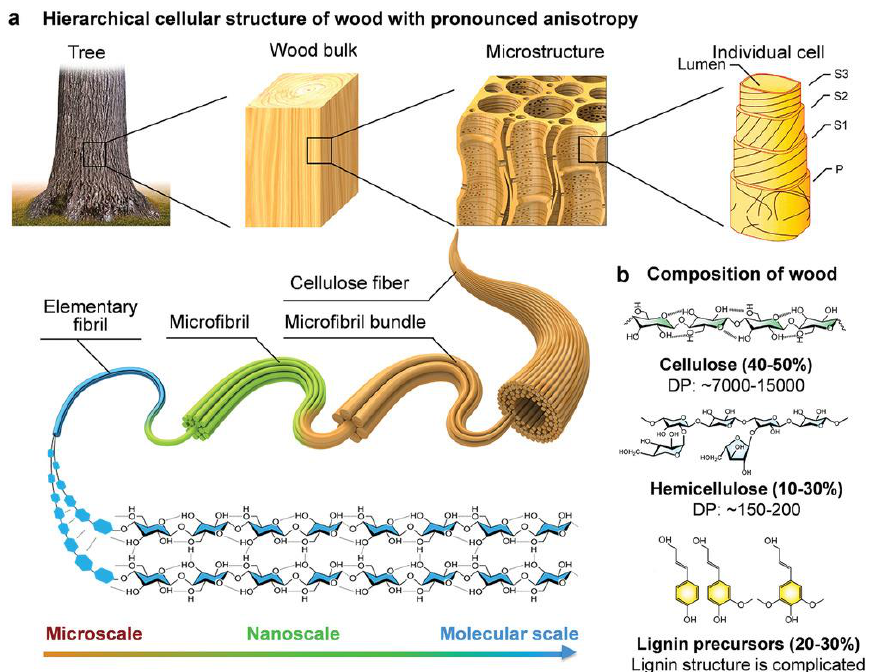
Figure 4. Hierarchical structure of wood and its composition. ( a ) Hierarchical cellular structure of wood is characterized by high anisotropy. The wood is composed of numerous cells that are mainly aligned along the longitudinal axis. The lignocellulosic wall of cells contains a primary layer (P) and a secondary layer (S), which in turn is divided into three sublayers (S1, S2, S3). The cell wall consists of microfibril bundles, which consist of microfibrils, nanofibrils, elemental fibrils, and macromolecular chains. ( b ) The three main components of wood are cellulose, hemicellulose, and lignin. Reprinted with permission from [27], copyright 2021, John Wiley & Sons.